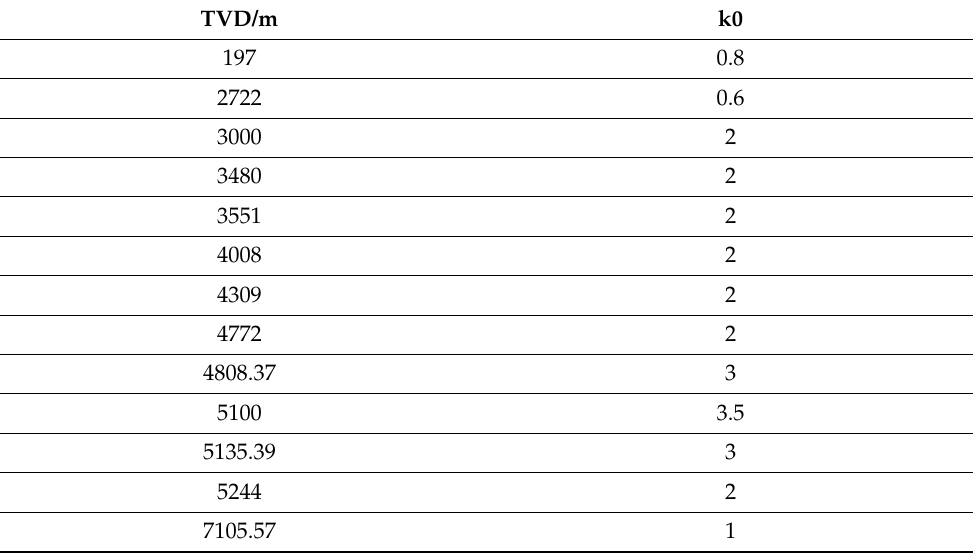
Table 2. Values of k0 for the FEM model.